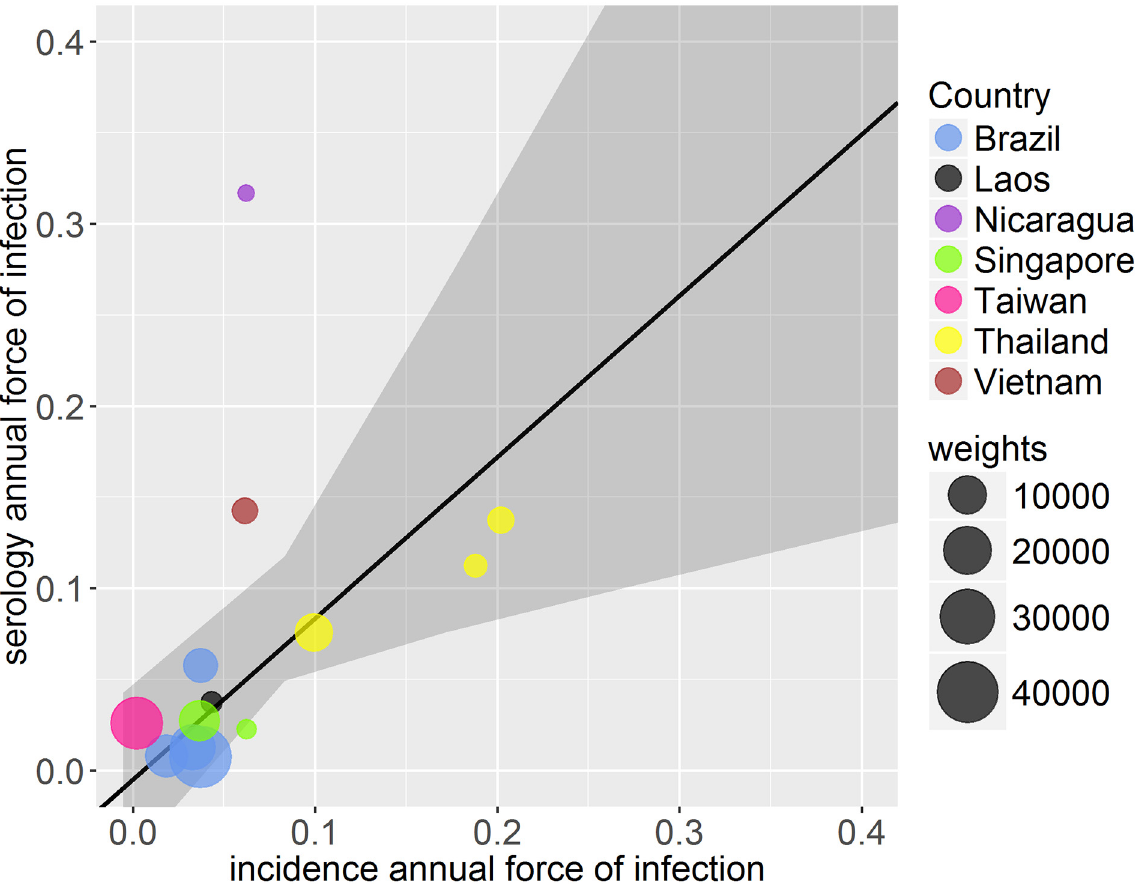
Fig 4. Comparison of weighted deming regression of force of infection estimates by country from cumulative incidence data and seroprevalence data. Each point is weighted depending on the error in both serology and incidence estimates, represented by the size of circles (larger circles indicating greater weight, i.e. smaller